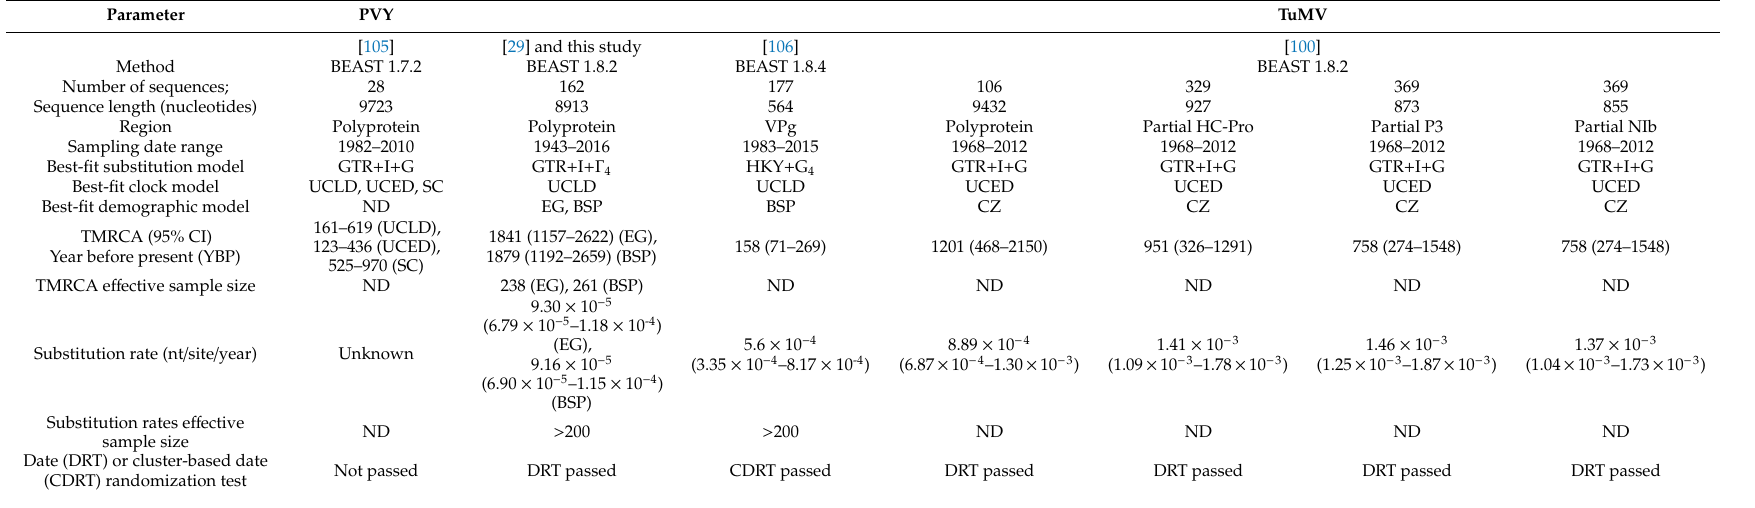
Table 1. Timescale analyses of potato virus Y and turnip mosaic